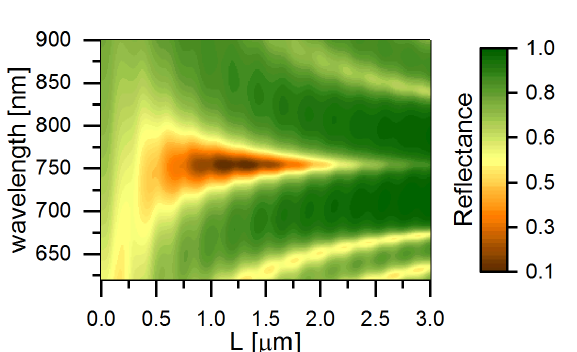
Figure 4. Reflectance spectra of the structure versus the cholesteric layer thickness L simulated by the Berreman method. The incident light is right-handed circular polarized (Figure 1b). Dark dip in the center is the TPP resonance. Reflectance minimum corresponds to the optimal coupling with equal losses through the cholesteric and the metasurface. The resonance bandwidth decreases with increasing L . Small resonances are observed at the edges of cholesteric stopband. Vertical periodic ripples are caused by additional reflection from the upper cholesteric interface; the rippling period equals the half-pitch of cholesteric helix.